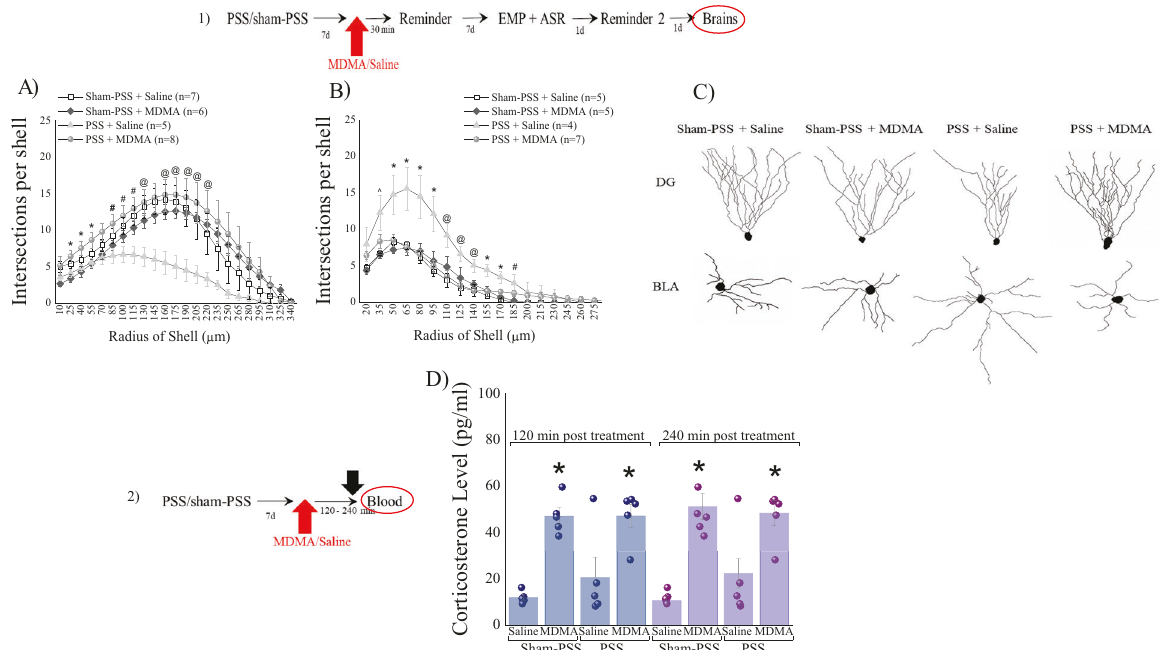
Fig. 2 MDMA treatment paired with a trauma-cue at 7 days after trauma, normalized morphological indicators. The top panel (1) depicts the experimental protocol. Vertical arrows represent intraperitoneal MDMA (5 mg/kg) or saline injection. Rats were exposed for 10 min to predator-scent stress (PSS) or to sham-PSS on day 0. On day 7, rats received MDMA (sham-PSS + MDMA: n = 10; PSS-exposed + MDMA: n = 10) or saline (sham-PSS + saline: n = 11; PSS-exposed + saline: n = 10) and 30 min later were exposed to a trauma-cue for 10 min. On Day 16, rats were sacri fi ced and their brains collected for morphological staining. A Sholl analysis for intersections per 15- μ m radial unit distance of dentate gyrus granule cells from the suprapyramidal blade. * Sham-PSS + MDMA ≠ PSS + MDMA, p < 0.05. # PSS + saline ≠ PSS + MDMA, p < 0.05. @ PSS + saline ≠ PSS + MDMA, sham-PSS + saline, p < 0.05. B Sholl analysis for intersections per 15- μ m radial unit distance of pyramidal neurons of the basolateral amygdala. ^ PSS + saline ≠ sham-PSS + saline & sham-PSS + MDMA, p < 0.03. * PSS + saline ≠ sham-PSS + saline & sham-PSS + MDMA & PSS + MDMA, p < 0.03. @ PSS + saline ≠ sham-PSS + saline & PSS + MDMA, p < 0.05. # PSS + saline ≠ sham-PSS + saline, p < 0.04. C Computer-generated reconstructions of dendritic trees from granule cells and pyramidal cells in all groups. (2) depicts the experimental protocol. Vertical arrows represent intraperitoneal MDMA (5 mg/kg) or saline injection. Corticosterone concentrations (pg/ml) measured at 120- and 240 min post MDMA treatment in sham-PSS treated with saline (Sham-PSS + saline, n = 10) or MDMA (Sham-PSS